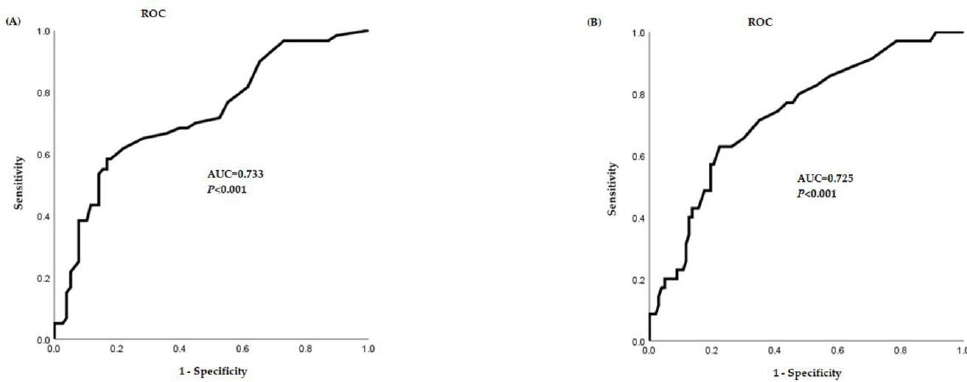
Figure 2. Receiver-operating characteristic (ROC) curve of FeNO cutoff value. ( A ) ROC curve of FeNO cutoff value in the asthma group. ( B ) ROC curve of FeNO cutoff value in the asthma rhinitis group. FeNO, fractional exhaled nitric oxide; AUC, area under curve.